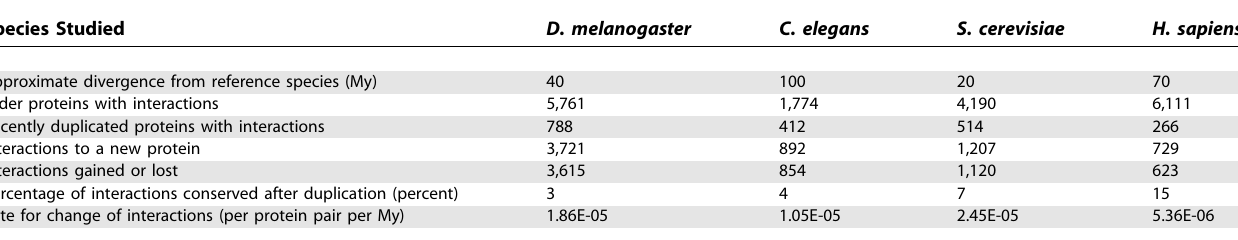
Table 1. Eukaryotic Species Had in the Recent Evolutionary Past a Fast Rate of Change of Interactions Species